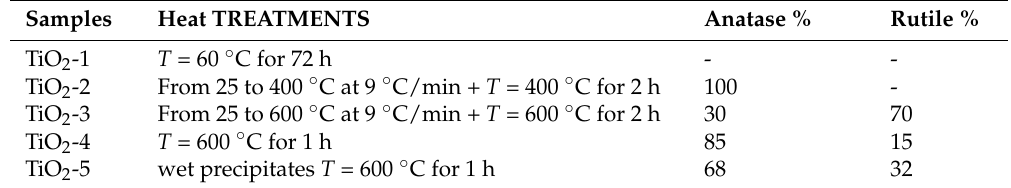
Table 2. Different percentages of anatase and rutile content depending on the different heat treatments of the TiO 2 nanoparticles.